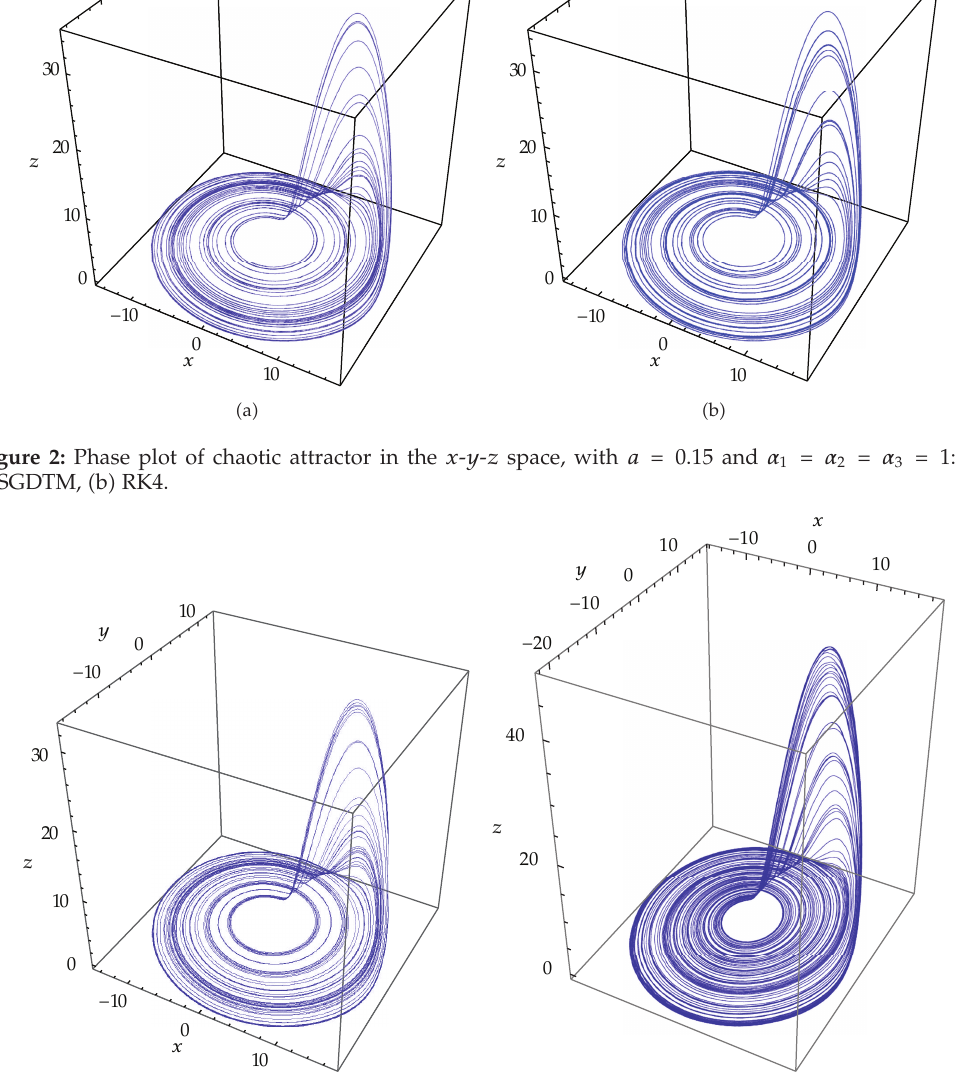
the time-fractional derivative α i , i (cid:8) 1 , 2 , 3. The e ff ective dimension Σ of (cid:3) 4.1 (cid:4) is defined as the sum of orders α 1 (cid:10) α 2 (cid:10) α 3 (cid:8) Σ . We can see that the chaos exists in the fractional-order